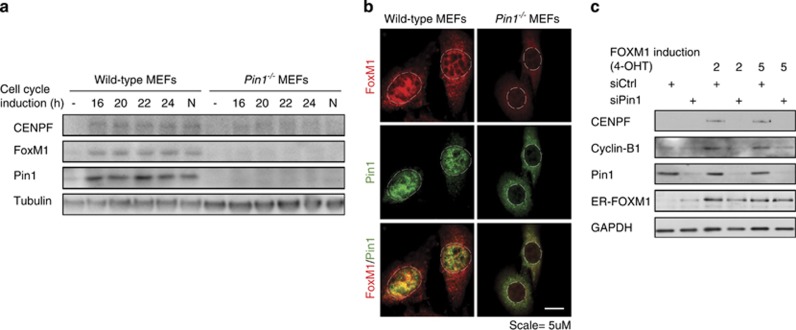
Pin1 is required for FOXM1 activity. (a) Expression of FOXM1 and CENPF is Pin1-dependent. Immunoblot analysis of the indicated proteins from lysates of wild type and Pin1−/− MEFs synchronized in G0 by serum deprivation or induced to enter cell cycle progression by 10% FCS for the indicated intervals. N=Nocodazole-induced G2/M arrest. (b) Pin1−/− MEFs show reduced FOXM1 expression under basal conditions. Immunocytochemical detection of Pin1 and FOXM1 in proliferating wild type and Pin1−/− MEFs. The dashed lines indicate the contours of the nuclei. A merged image is shown to compare co-localization. (c) The induction of the FOXM1 target genes CENPF and Cylin-B1 by 4-OHT activatable FOXM1-ER is Pin1-dependent. U2OS cells stably expressing FOXM1-ER were transfected with control siRNA (siCtrl) or siRNA against Pin1 (siPin1). After 24 h they were exposed to 2 or 5μM 4-OHT and 24 h later processed for immunoblot analysis of the indicated proteins. Note that the ER-FOXM1 band is not significantly reduced by Pin1 knockdown, indicating stabilization due to the ER fragment.